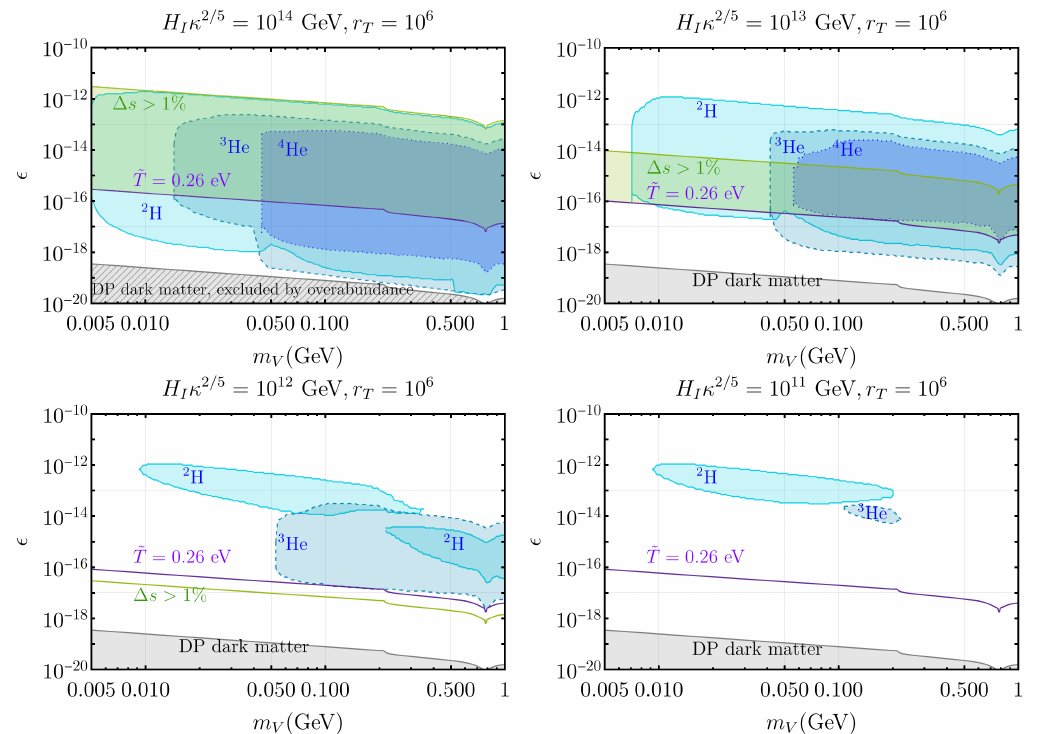
Figure 8 . The same as Figure 7 but for low reheating scenario r T = 10 6